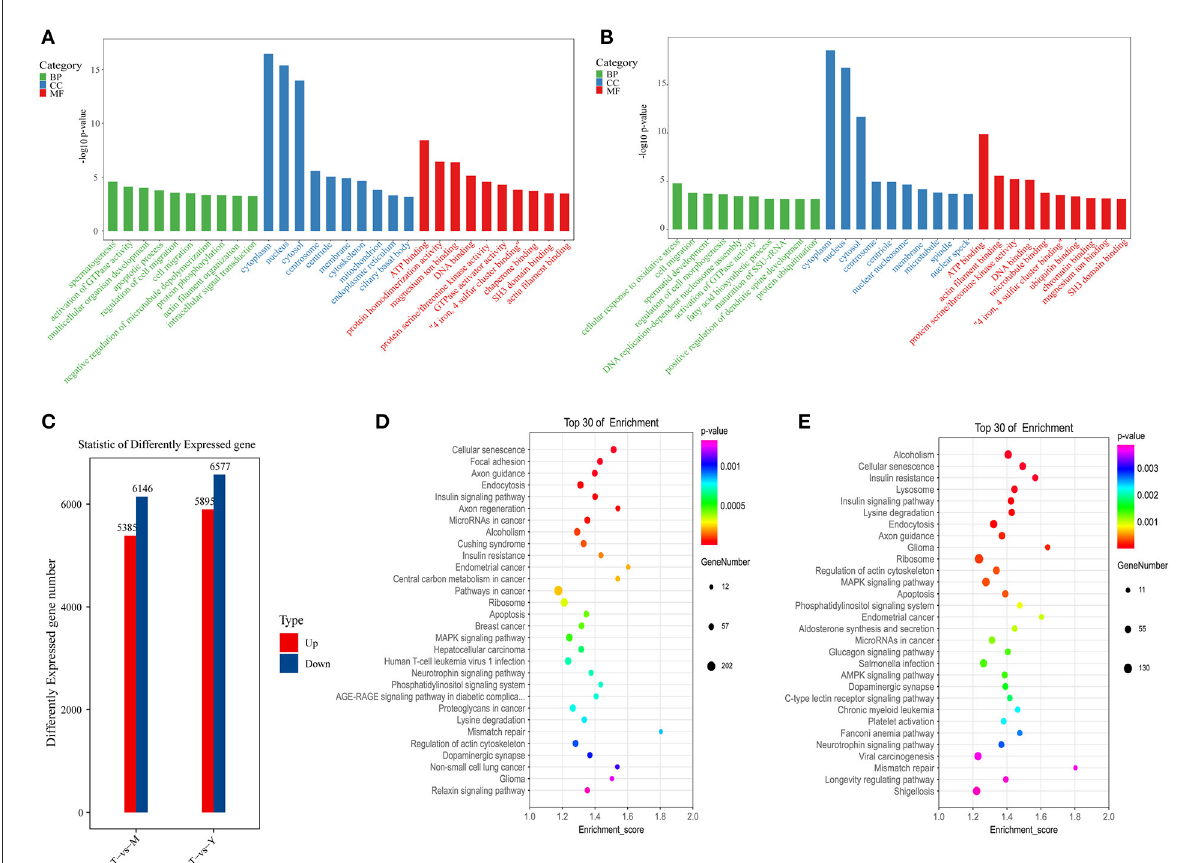
FIGURE6 Functional enrichment analyses for DEGs. (A) GO analyses for the T vs. Y group. (B) KEGG analyses for the T vs. Y group. (C) DEG statistics. (D) GO analyses for the T vs. M group. (E) KEGG analyses for the T vs. M